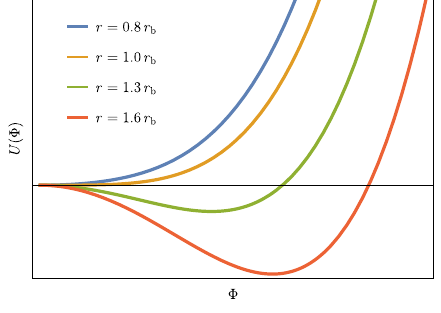
Figure 2 . Sketch of the pro(cid:12)le of the e(cid:11)ective potential U ((cid:8)) for decreasing radii from r = 1 . The minimum of the potential is negative for r > r b . From r < r b and inwards, the minimum of the potential is zero, so the background (cid:12)eld is (cid:8) = 0 in that